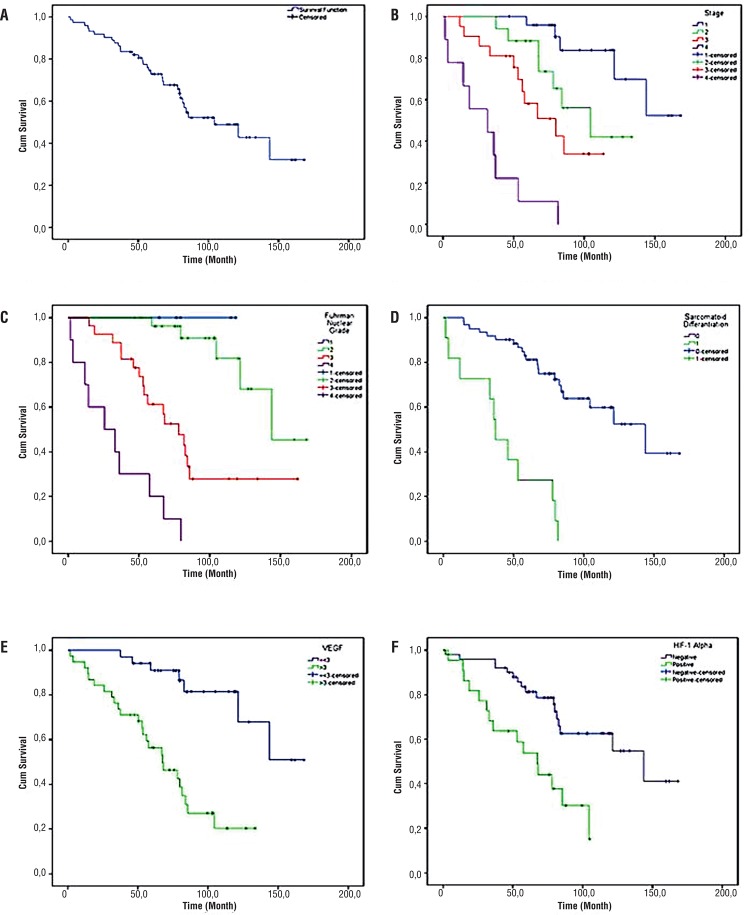
Relationship of histopathological and immunohistochemical characteristics with survive. A) Survival function of patients with RCC, B) Survival function of patients with RCC by stage, C) Survival function of patients with RCC by Fuhrman Nuclear Grade, D) Survival function of patients with RCC by Sarcomatoid differentiation. E) Survival function of patients with RCC by VEGF, F) Survival function of patients with RCC by HIF-1 Alpha.